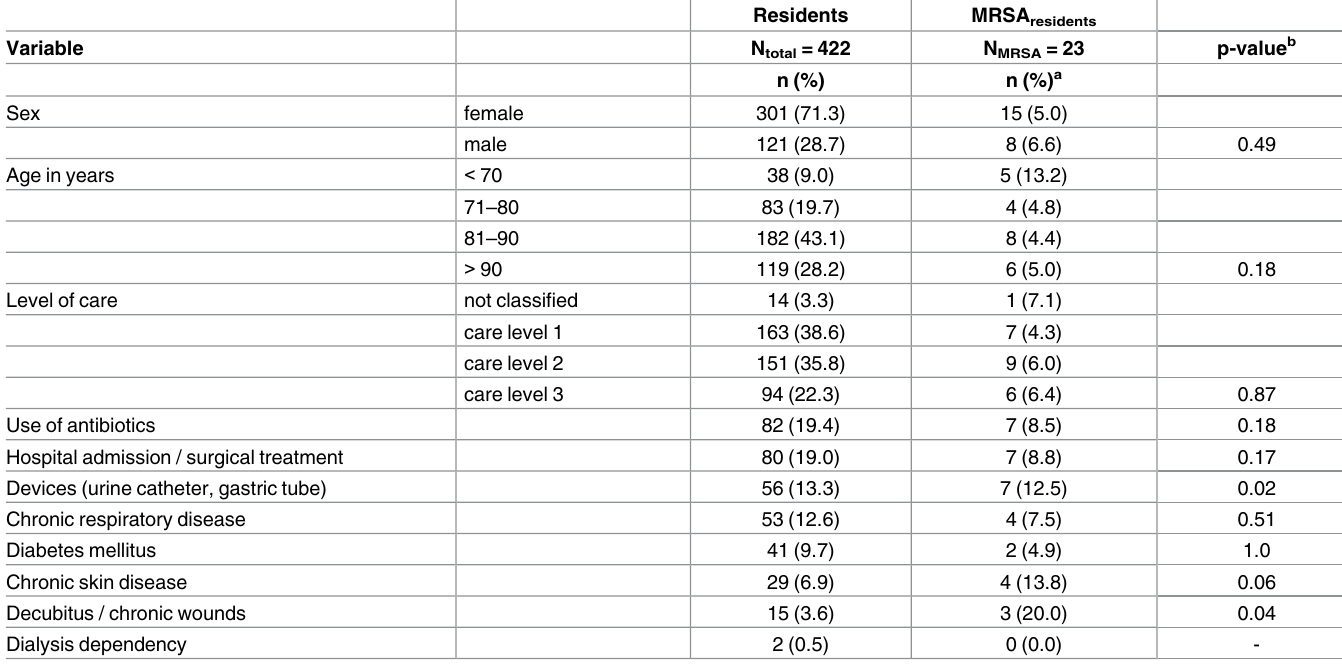
Table 2. Description of study population (residents) and MRSA-positive cases (MRSA residents ) among residents in nursing homes. Residents MRSA